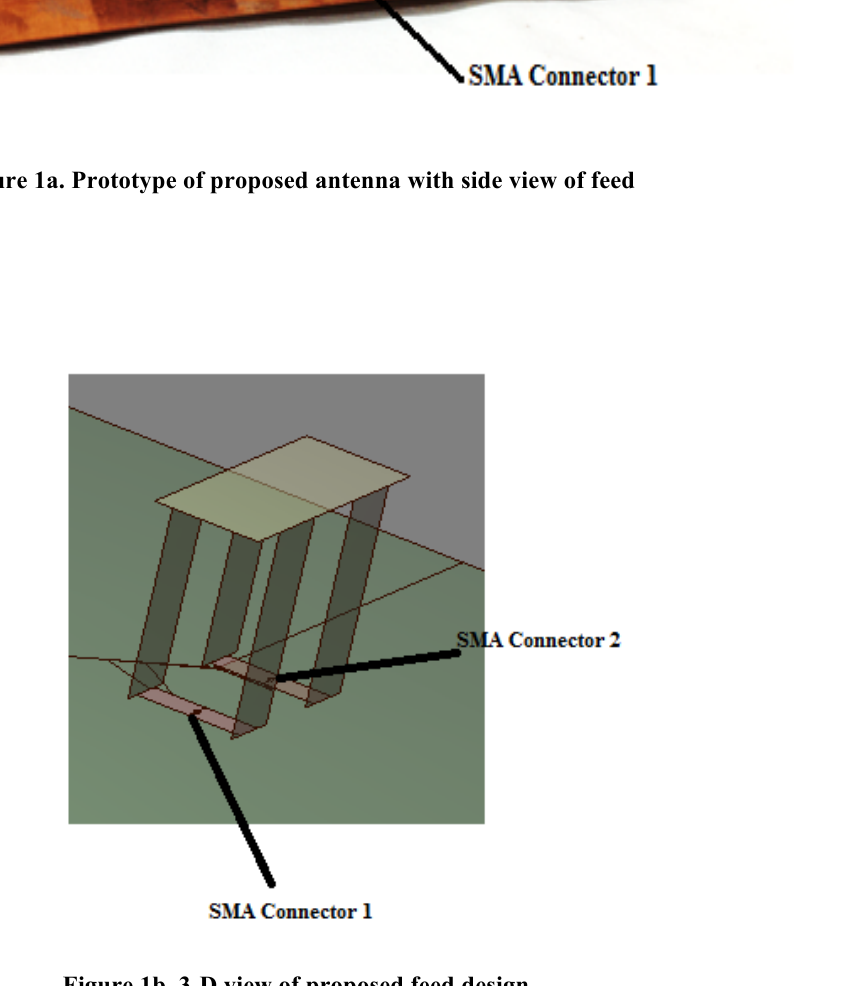
Figure 1b. 3-D view of proposed feed